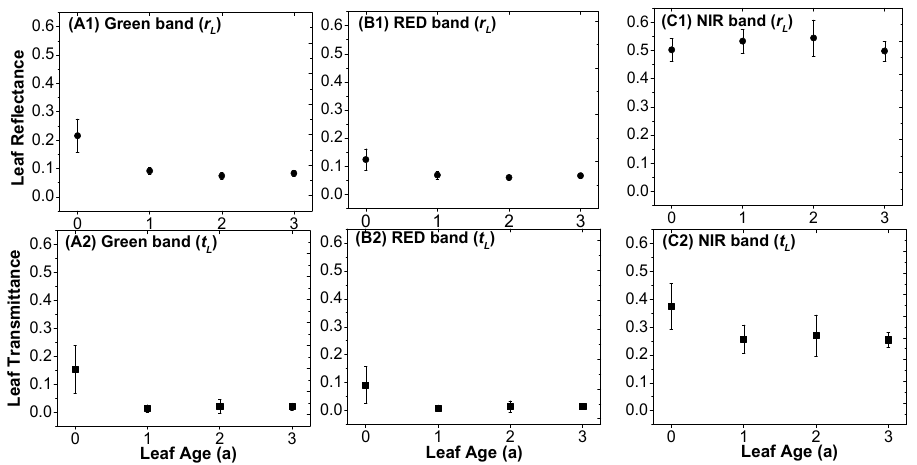
Figure 6. Leaf reflectance ( r L , A1 – C1 ) and transmittance ( t L , A2 – C2 ) for Chinese fir leaves at different ages (0–3 a) at three (green, red and NIR) short-wave bands. Leaves were collected on 5 May 2017.